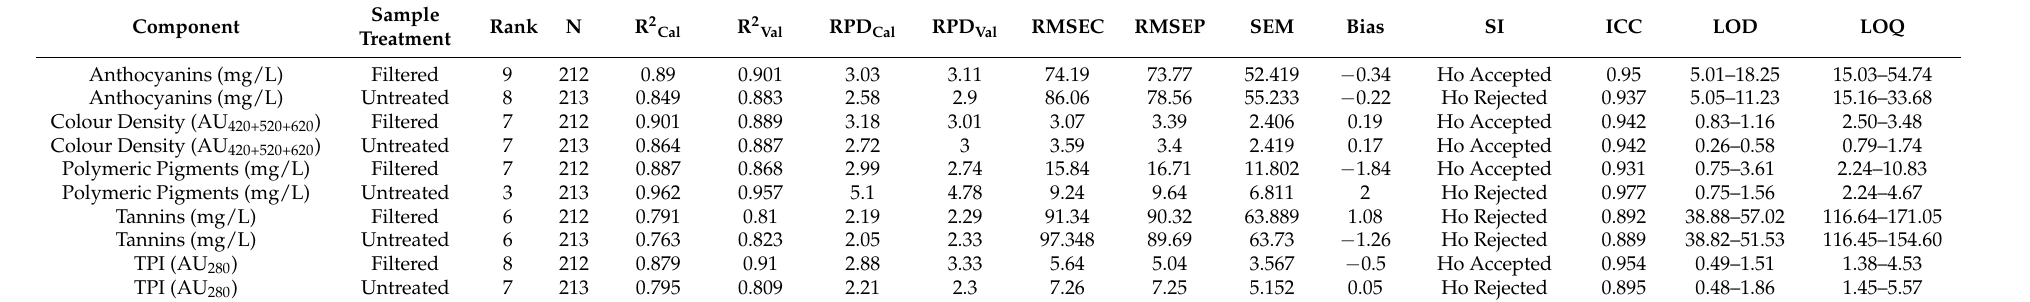
Table 4. Summary Statistics for filtered and turbid samples using direct-reflection Fourier-transform near-infrared (DR-FT-NIR) spectroscopy.